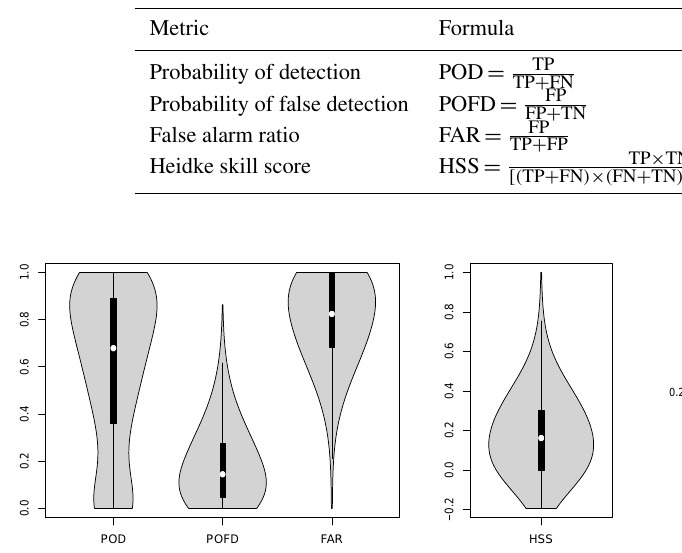
Figure 4. Comparison of POD for different hourly measured rain- fall quantities as well as FAR for different predicted rainfall quanti- ties. RMSE was compared for different measured rainfall quantities. All data points from 2013 were used for the calculation of the statis- tics. Thresholds for the three rainfall classes were set according to the first and third quartiles of the measured hourly rainfall quanti- ties.